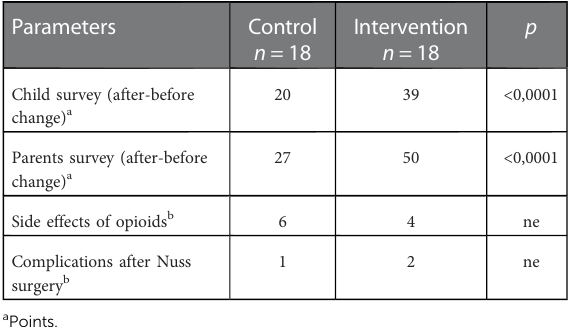
TABLE 3 Postoperative data from patients in both groups.